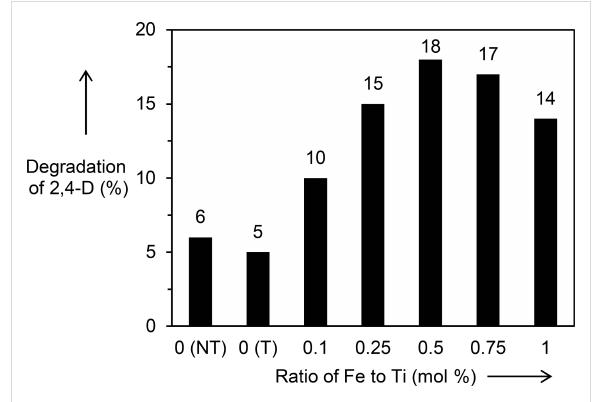
Figure 8: Photocatalytic degradation of 2,4-D on TiO 2 (NT), TiO 2 (PD_T) and the series of Fe 2 O 3 /TiO 2 (PD) samples. NT represents no treatment, PD shows the samples were prepared by photodeposition method, and T indicates an additional photodeposition treatment was carried out on the sample.